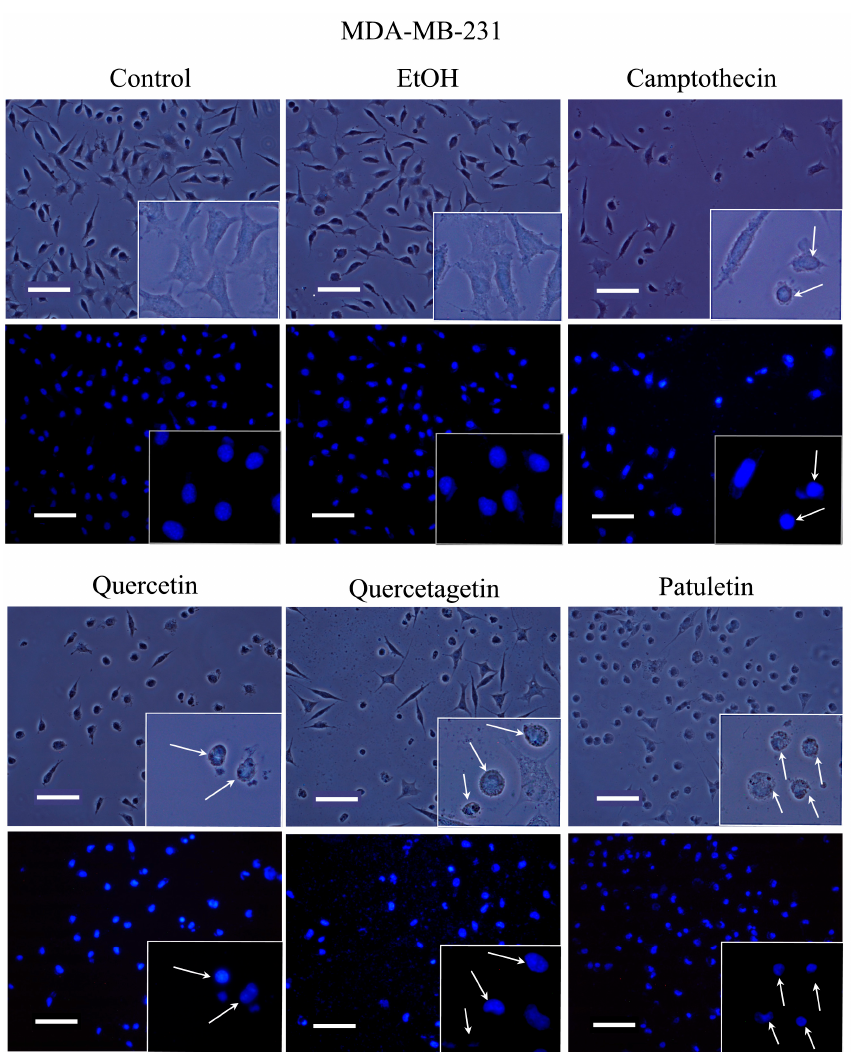
Figure 7. Morphology and DAPI staining. MDA-MB-231 cell cultures were exposed to quercetin, quercetagetin and patuletin at the aforementioned IC 50 values. Camptothecin was used as a positive control for apoptosis. The phase-contrast images evidenced cellular shapes under the different experimental conditions. The control and EtOH cells had extended cytoplasm with chromatin distributed in the nuclear space, as shown by the fluorescent distribution of DAPI. After treatment, both the cytoplasm and nucleus were contracted, and several apoptotic bodies were visible (arrows), Scale bars 100 microns.